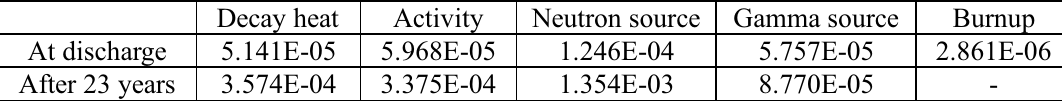
Table II. Relative validation error of surrogate model (-).